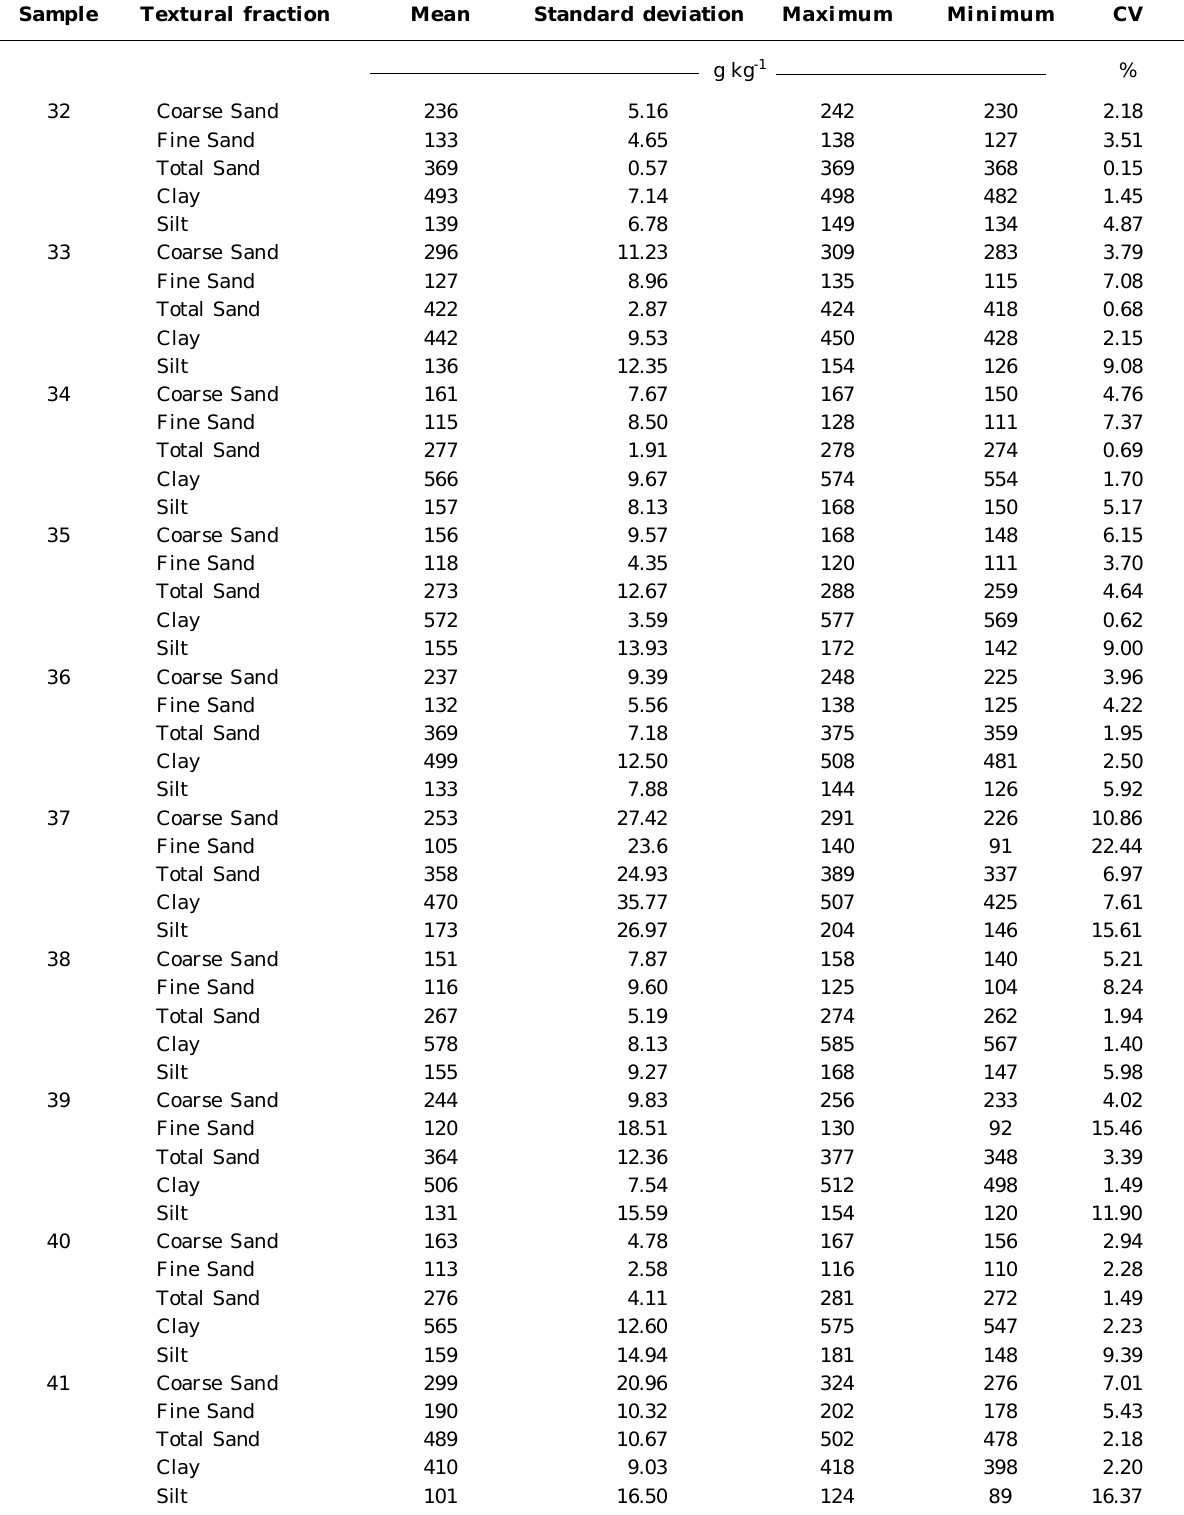
Table 5. Descriptive statistics of the results from particle-size analysis of 20 Clay soil samples (n = 4